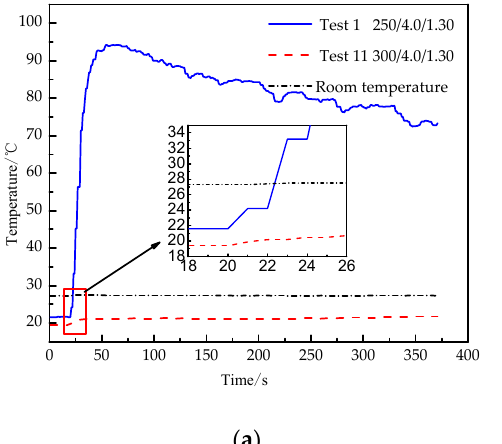
Figure 4. Displays after experiments of constant-stress shear plate (the maximum width of convex area of each constant-stress shear plate is shown in the figures).